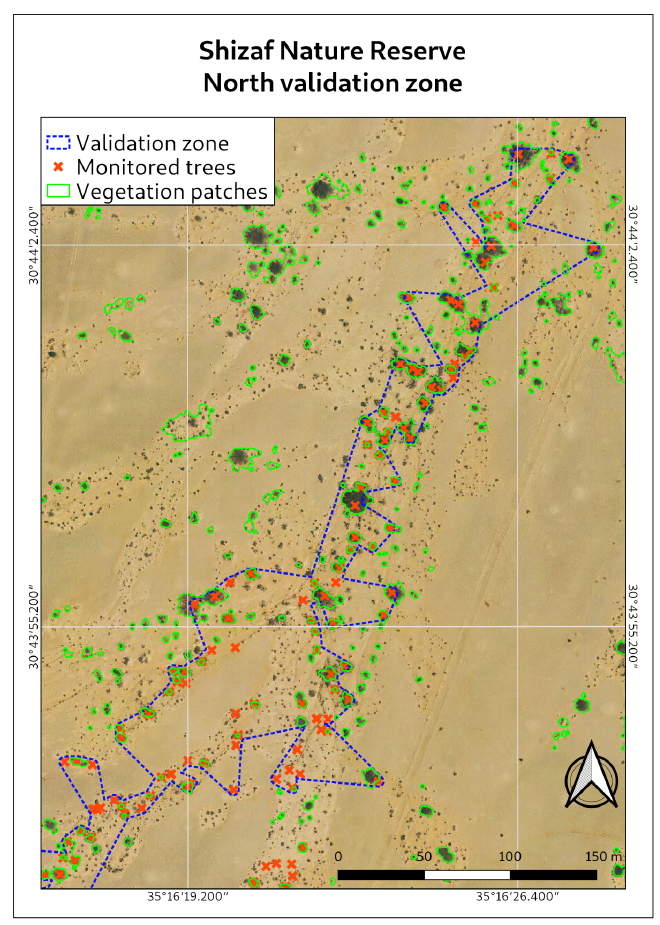
Figure 5. Validation zone (blue dashed line) in the Shizaf study area. The monitored tree locations appear as red